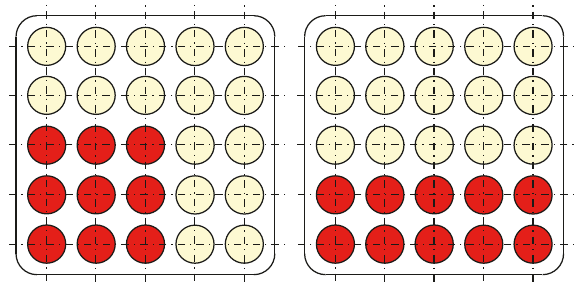
Figure 8: Heating pattern condition of the bundle geometry